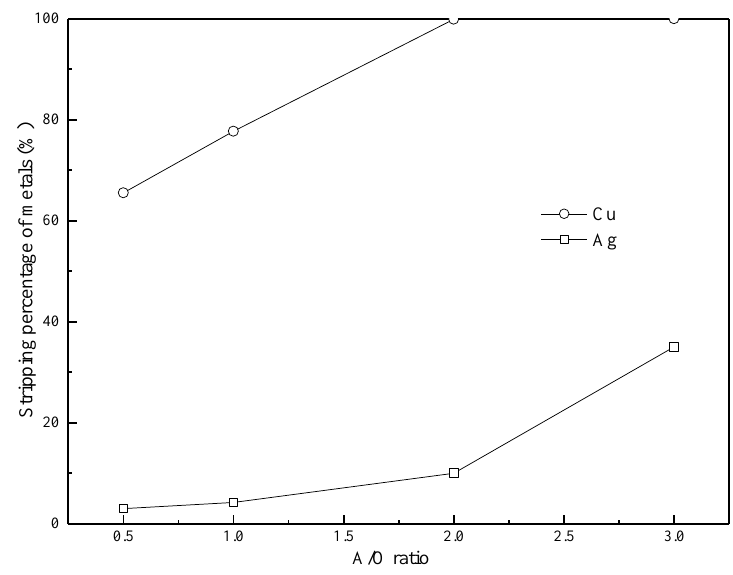
Figure 7. Effects of the A/O ratio on the stripping percentages of Cu(II) and Ag(I) using 4 mol/L HNO 3 .